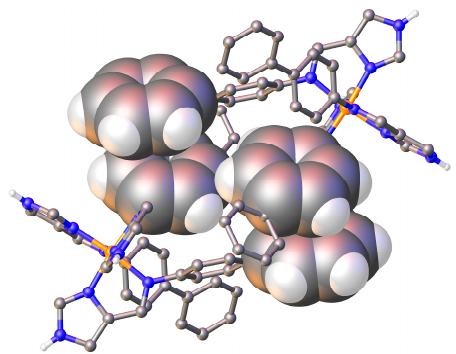
Figure 6. View of the π - π interactions in fac -[Fe(4-ima-Bp) 3 ](BF 4 ) 2 ·3.5MeCN 5 .